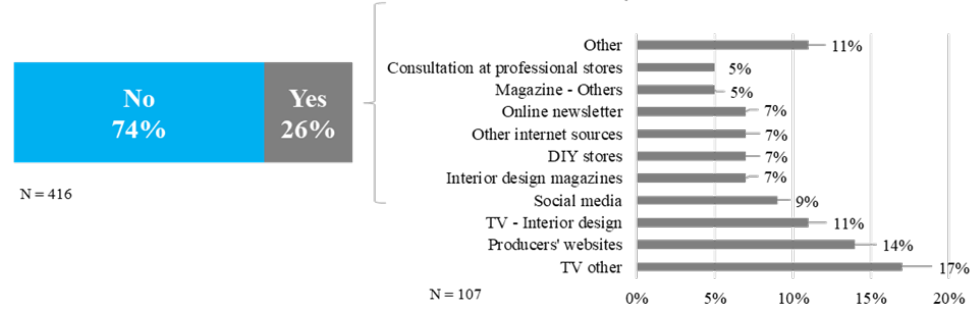
Figure 4. Influencing role of social environment in the stage of awareness.